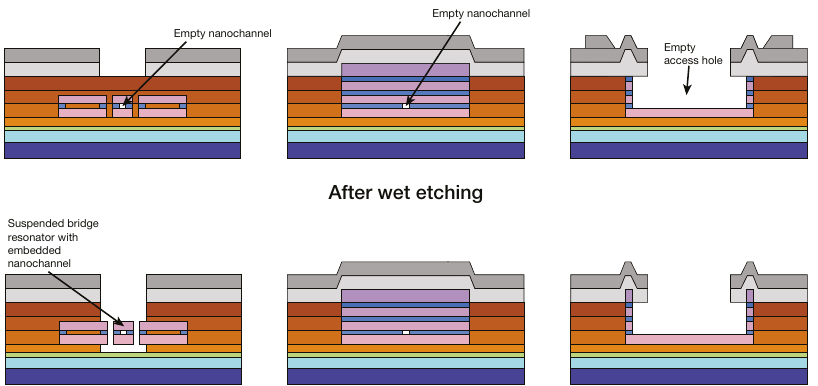
Figure 2. Illustrations of the suspended nanochannel microbridge resonator at different stages of the process to empty the nanochannel and release the bridge. For the sake of clarity, the size proportions of the different elements of the suspended nanochannel microbridge resonator (access holes, electrodes-resonator gaps, bridge nanochannel aperture, etc. ) are modified compared to the actual device. ( a ) Simplified 3D illustration of the suspended nanochannel bridge resonator once empty and released. The dashed lines indicate the four different cross-sections. ( b ) Cross-section D-D’ of the fabricated suspended nanochannel bridge resonator showing all the layers of the AMS 0.35 μ m commercial CMOS technology. PROT1 and PROT2 correspond to passivation layers; MET1, MET2, MET3, and MET4 to metal layers; VIA1, VIA2, and VIA3 to contact layers; FOX, ILDFOX, IMD1, IMD2, and IMD3 correspond to insulator layers. The evolution of the cross-section D-D’ is not shown, since it remains unchanged after the completion of all the carried out processes. ( c ) Cross-sections A-A’, B-B’, and C-C’ showing the bridge with the built-in nanochannel and the access holes at different stages of the emptying and releasing fabrication process.